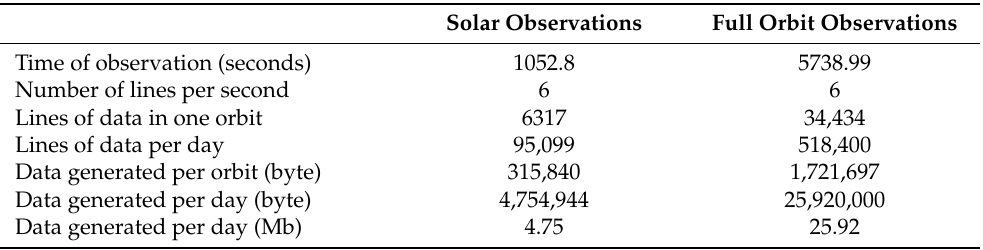
Table 8. Data generation for RMCSat payload. An additional 40% margin is added to the minimum observation time of 752 s and 50 bytes is assumed per line of data